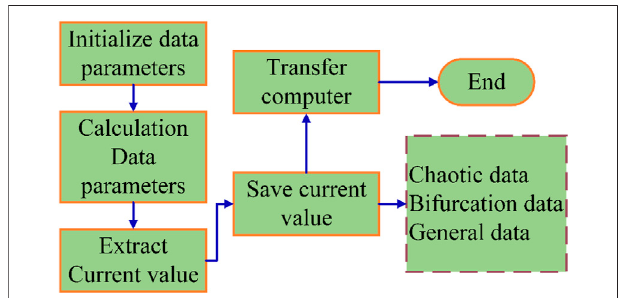
FIGURE 2 | Flow chart for judging system